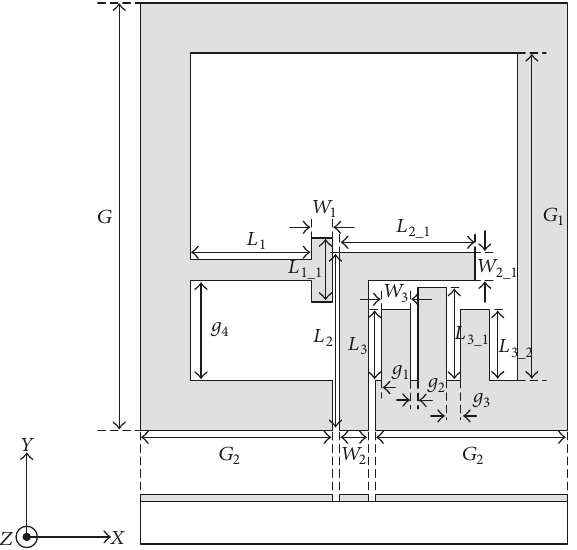
Figure 1: Structure and dimensions (in mm) of the proposed = 16 , 𝑊 = antenna: 𝐺 = 114 , 𝐺 1 = 86 , 𝐺 2 = 53 , 𝐿 1 = 35 , 𝐿 1 1 _ 1 4 , 𝐿 = 45 , 𝑊 = 5 , 𝐿 = 35 , 𝑊 = 5 , 𝐿 = 20 , 𝐿 = 2 2 2 _ 1 2 _ 1 3 3 _ 1 24 , 𝐿 = 15 , 𝑊 = 5 , 𝑔 = 0.5 , 𝑔 = 2 , 𝑔 = 3 , and 𝑔 = 25 . 3 _ 2 3 1 2 3 4